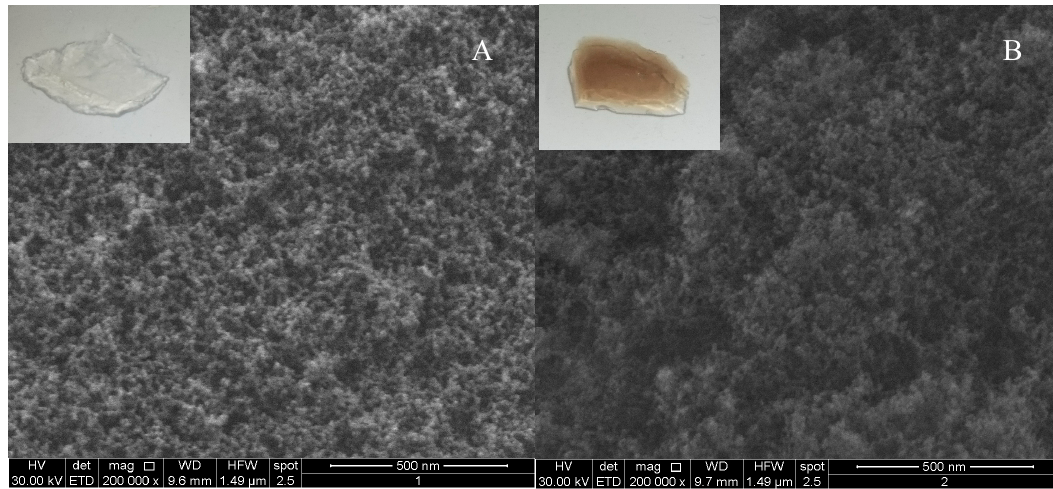
Figure 4. SEM images of ( A ) reference SA and ( B ) EuSiGel. Pictures of the corresponding samples are also reported (upper-left corner).